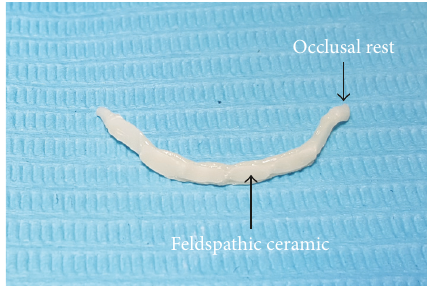
Figure 3: CAD/CAM zirconium bar prior to cementation.